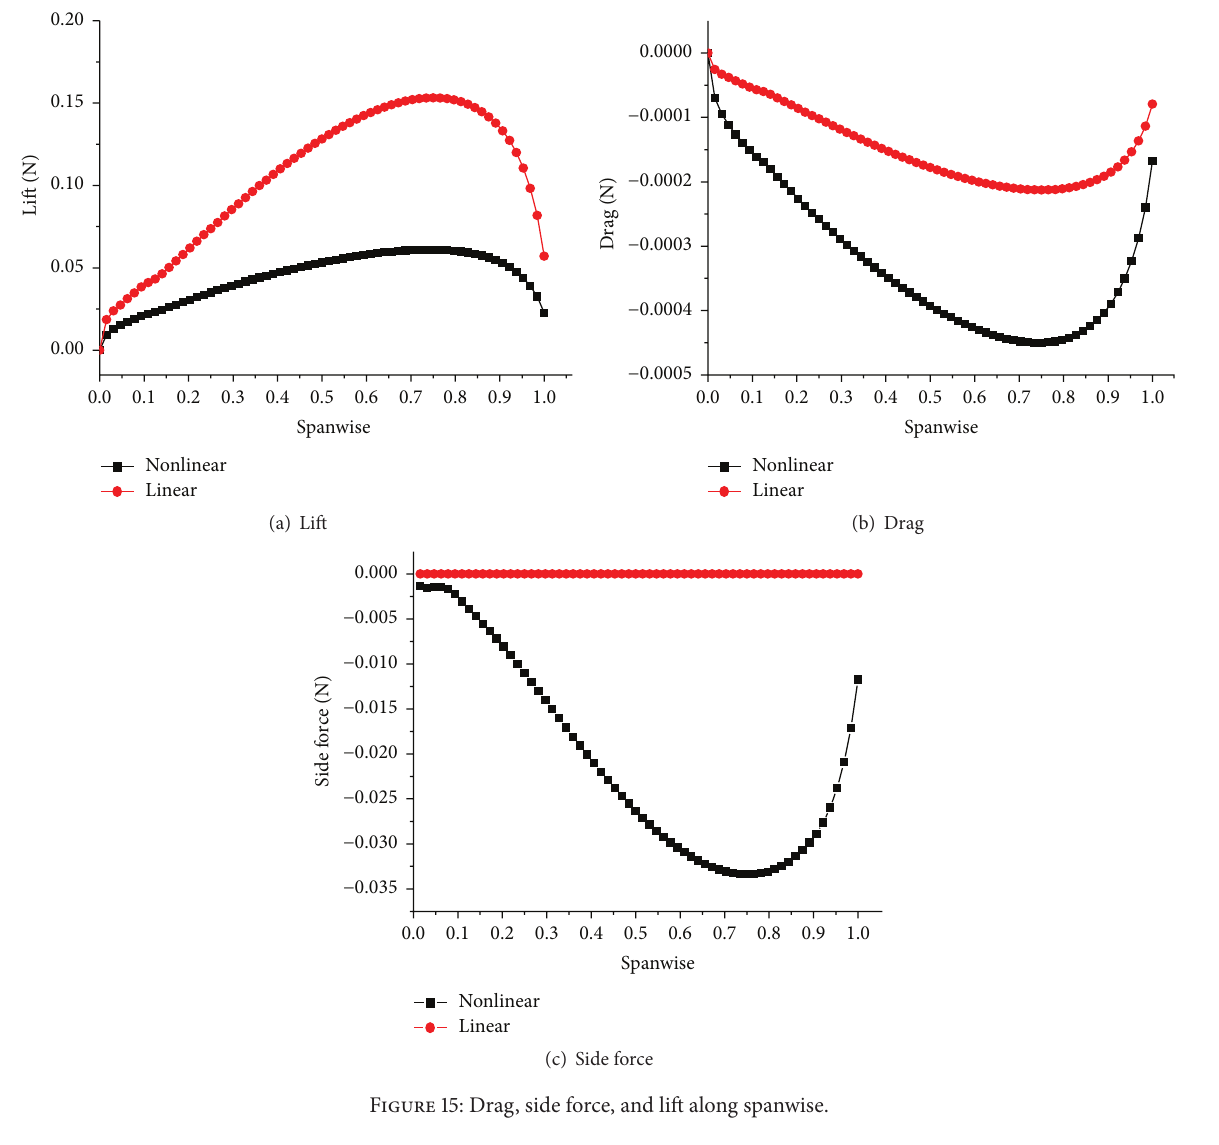
Figure 15: Drag, side force, and lift along spanwise.